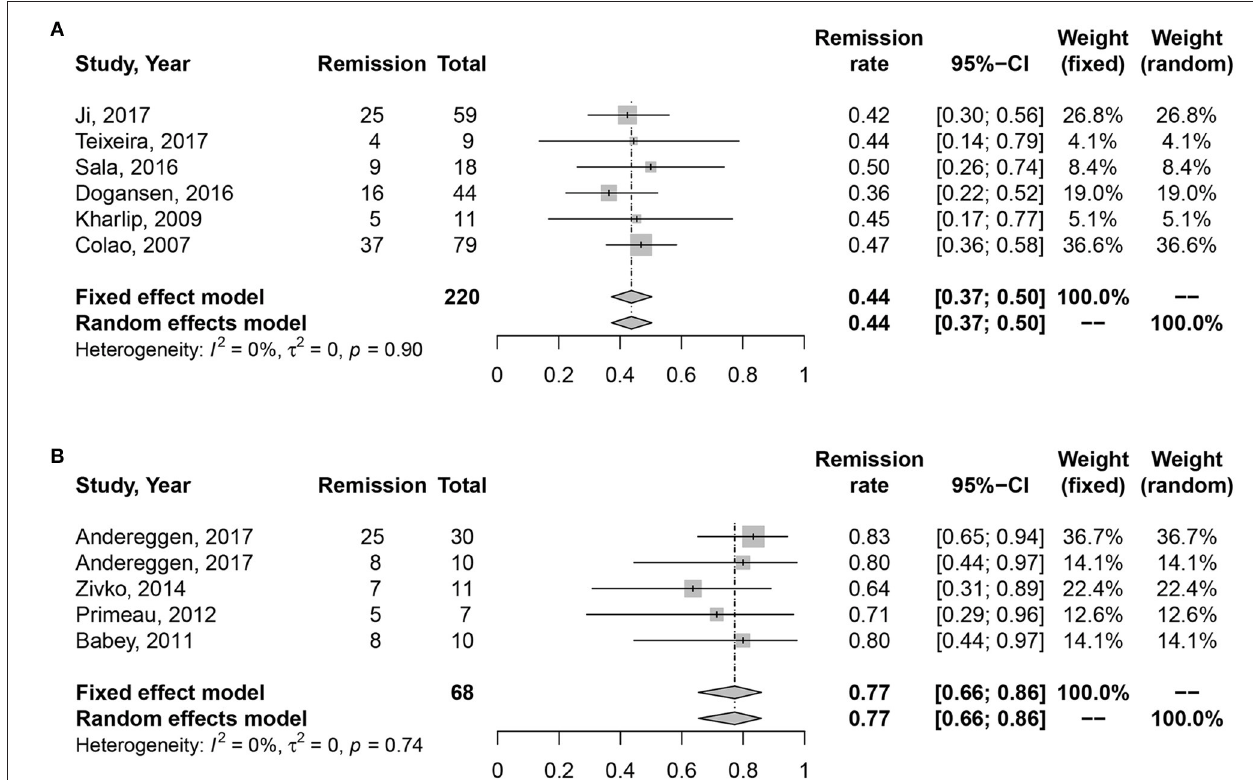
FIGURE 4 | Forest plots describing effects of medication vs. surgery as first-line treatment on the long-term remission rate of macroprolactinomas. (A) Long-term remission rate in medication cohort for macroprolactinomas. (B) Long-term remission rate in surgery cohort for macroprolactinomas.